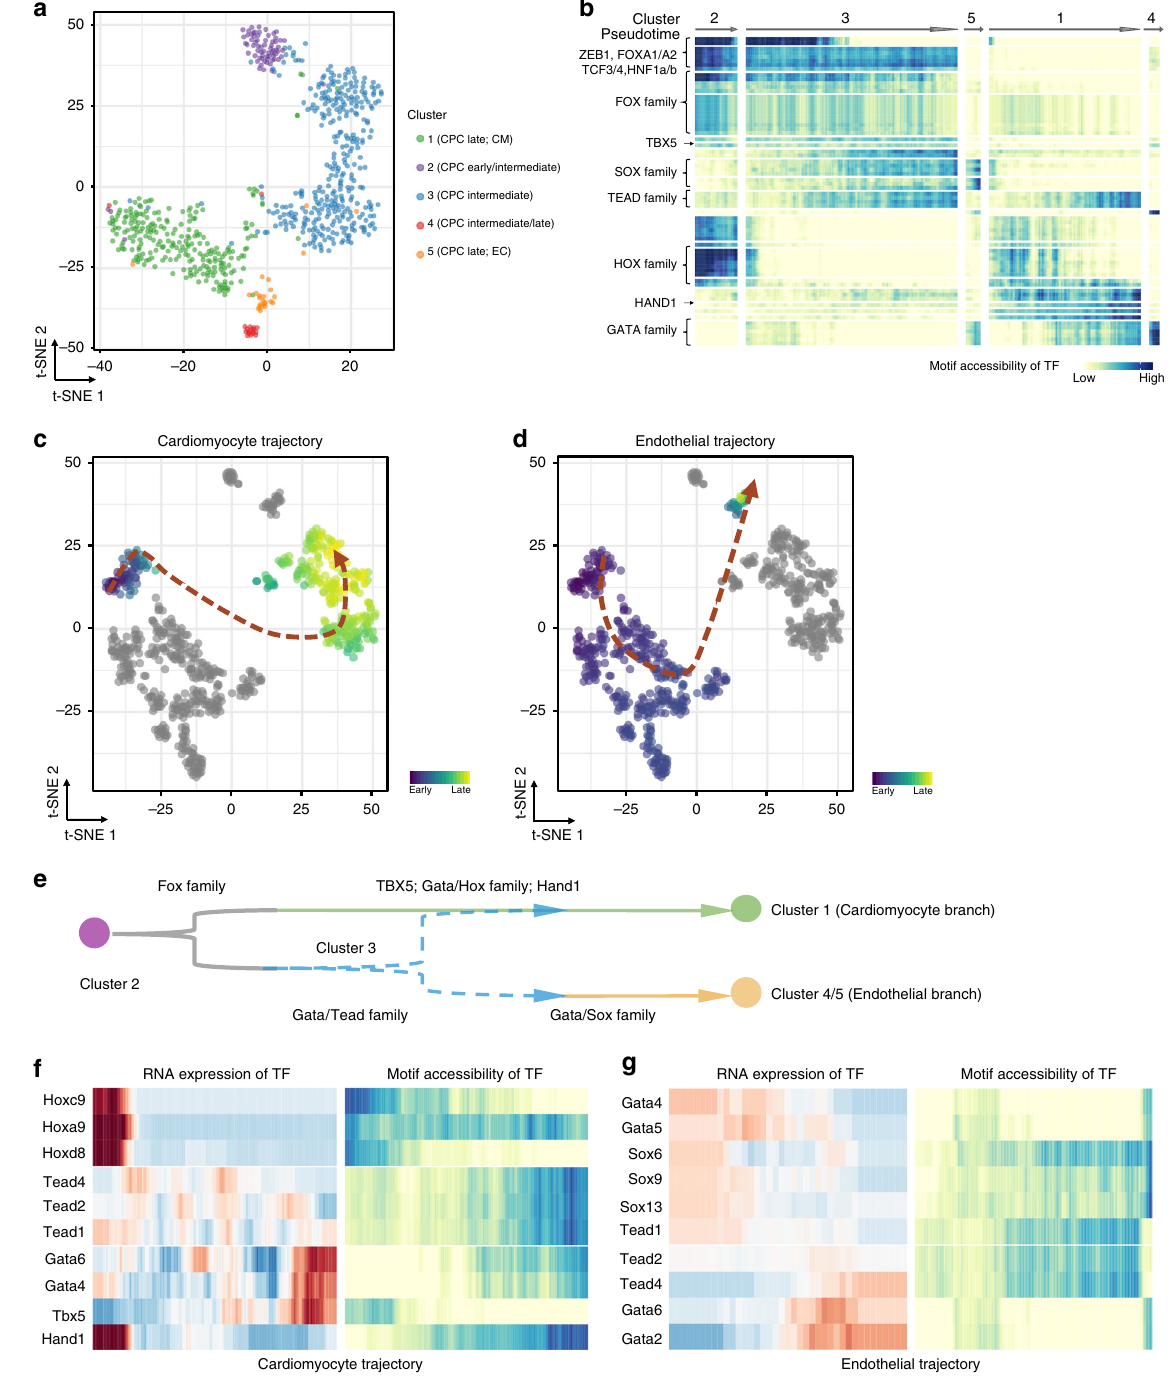
Fig. 8 Chromatin accessibility of transcription factor binding sites. a t-SNE showing clustering of Z -scores of TF motif accessibility. Colors denote the same clusters as Fig. 7b. b Heatmap showing smoothened Z -scores of TF motif accessibility across de fi ned clusters. Source data are provided in the Source Data fi le. c , d t-SNE visualization of highlighted single-cells progressing through the inferred ( c ) cardiomyocyte, ( d ) endothelial developmental trajectory (red dashed lines). Cells used for inference are colored by Z -scores of TF motif accessibility. All other cells are shown in gray. e Inferred model showing TF dynamics during Isl1 + CPC developmental bifurcation. f , g Smoothened heatmap showing dynamic RNA expression and motif accessibility of indicated TFs during cardiomyocyte ( f ), endothelial ( d ) pseudotime trajectories for gene-motif pairs (RNA:ATAC pairs). EC, endothelial cell. CM,